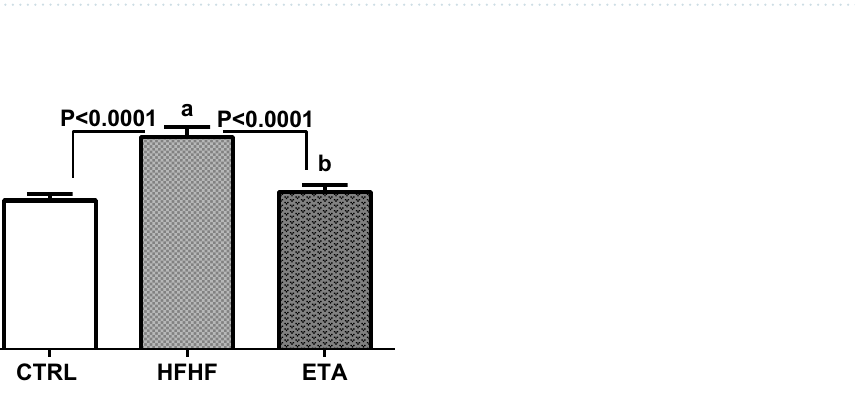
Figure 2. ETA attenuates HFHF-induced adipocyte dysfunction. Comparison data from the HFHF-fed rats and standard chow-fed rats (CTRL) are shown: ( a ) serum TNF-α level, ( b ) serum leptin level, and ( c ) serum adiponectin level. Data are presented as the mean ± SD values and are representative of a single independent experiment ( n = 6). Statistical analysis was performed using one-way ANOVA, followed by Tukey’s multiple comparison tests. a Significantly different from the normal control group. b Significantly different from the HFHF group. Differences were considered significant if the p-value was < 0.05. CTRL control, ETA etanercept, HFHF high-fat high-fructose diet, TNF‑α tumor necrosis factor-alpha.